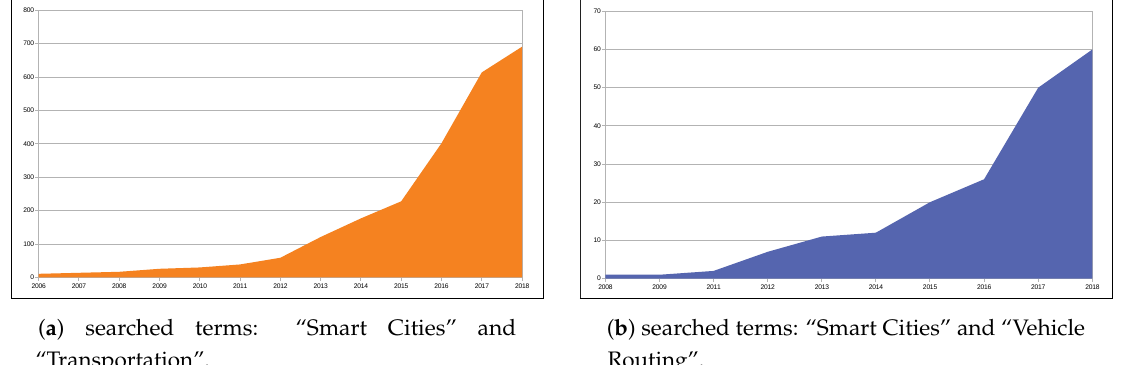
Figure 1. Raw number of published documents (information extracted from Scopus on 20 June